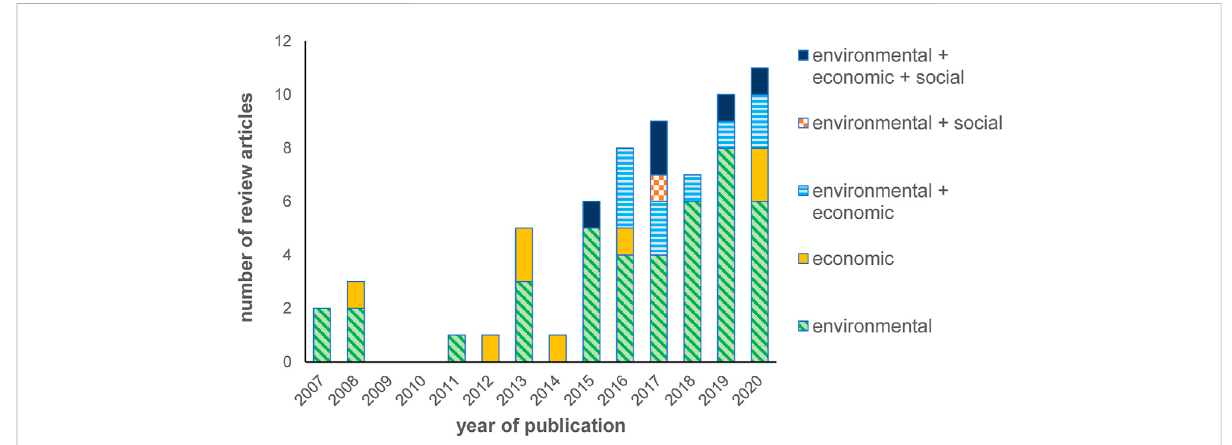
FIGURE 2 Number of systematic review articles about agroforestry outcomes published per year (n = 64) with type of outcome addressed (the year 2020 only contains articles until October 2020). The number of articles is increasing over time. Most articles address environmental outcomes, followed by economic outcomes. Only few articles consider social